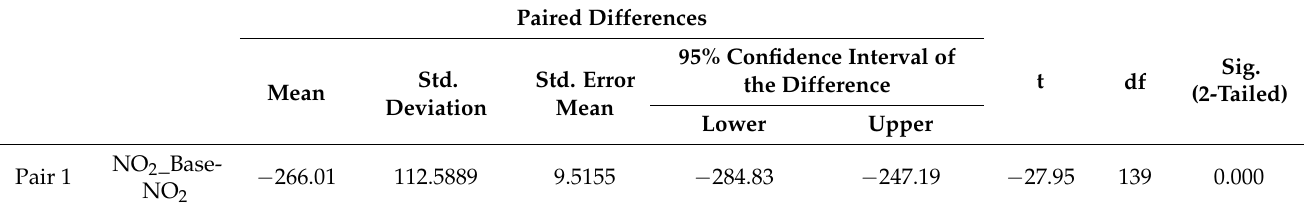
Table 3. Paired Samples